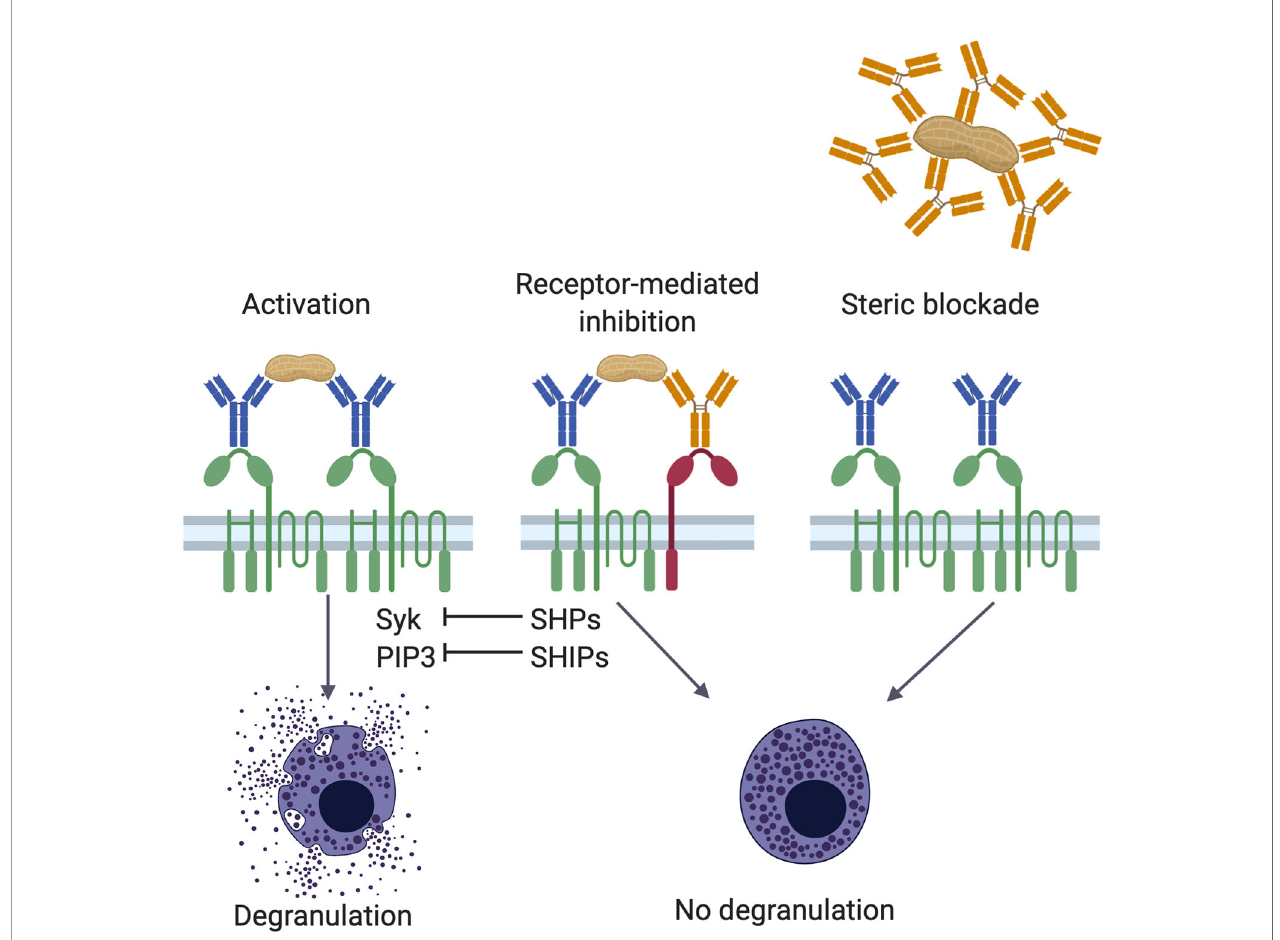
FIGURE 1 | Mechanisms of IgG mediated inhibition. Antigen encounter by neighboring Fc ϵ RI (green)-bound IgE (blue) on the surface of mast cells or basophils induces receptor crosslinking, phosphorylation of cytosolic immunoreceptor tyrosine-based activation motif (ITAM) sequences in the tetraspanning b - and disul fi de- linked g -chain dimers, and activation of various signaling pathways involving protein tyrosine kinases, such as Syk, and inositol intermediates, including PIP 3 (left panel). These positive signals culminate in the degranulation of the cell. Allergen speci fi c IgG antibodies (orange) counter the effects of IgE in two ways, receptor- mediated inhibition (center panel) and steric blockade (right panel). In receptor-mediated inhibition, when polyvalent allergens are simultaneously engaged by Fc ϵ RI- bound IgE and Fc g RIIb (red)-bound IgG, crosslinking of the two receptors leads to phosphorylation of Fc g RIIb cytosolic immunoreceptor tyrosine-based inhibition motifs (ITIMs). These recruit protein tyrosine phosphatases and inositol phosphatases, such as SHPs and SHIPs, respectively. Phosphatases can neutralize phosphoprotein (such as Syk) and phospholipid (such as PIP 3 ) signaling intermediates induced by Fc ϵ RI activation. In steric blockade, IgG antibodies bind the allergen before it reaches receptor-bound IgE. By masking IgE binding epitopes, these blocking IgG antibodies inhibit interaction with IgE and thereby prevent Fc ϵ RI- mediated mast cell